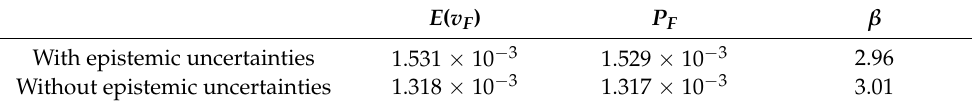
Table 6. Reliability indicators.